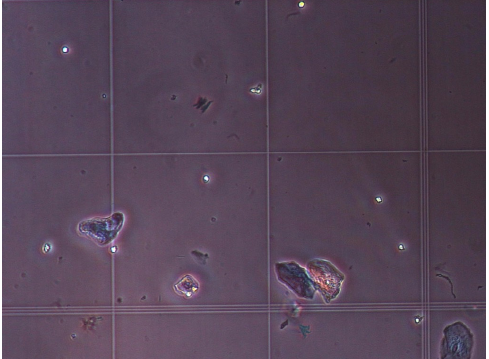
Figure 7. The microscopic images of the hemocytometer showing neutrophil and epithelial cells.